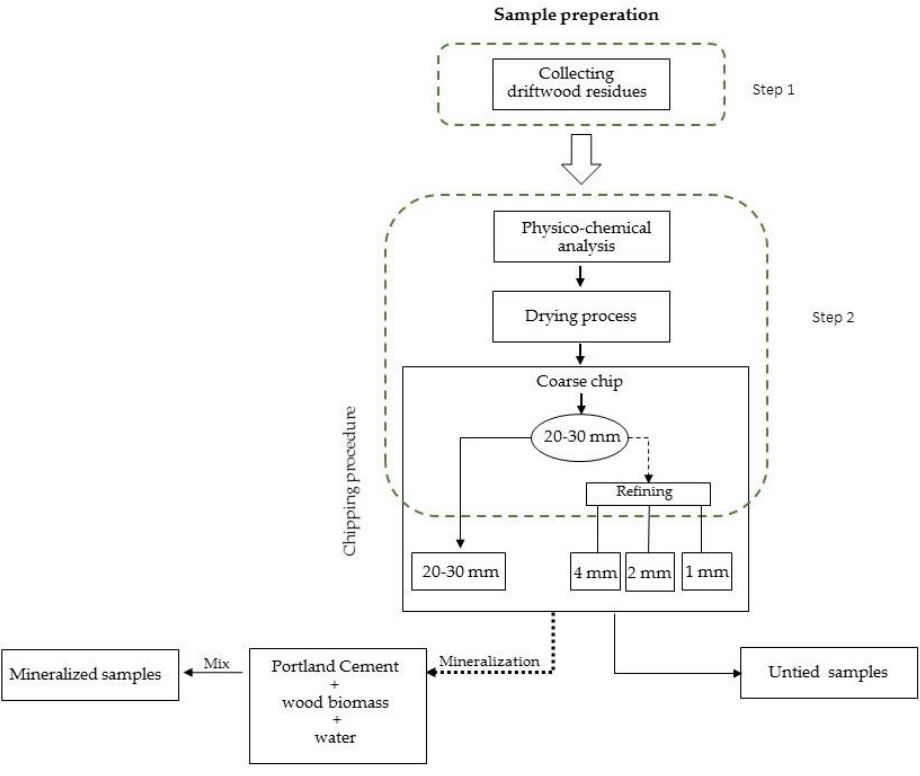
Figure 3. Schematic procedure.